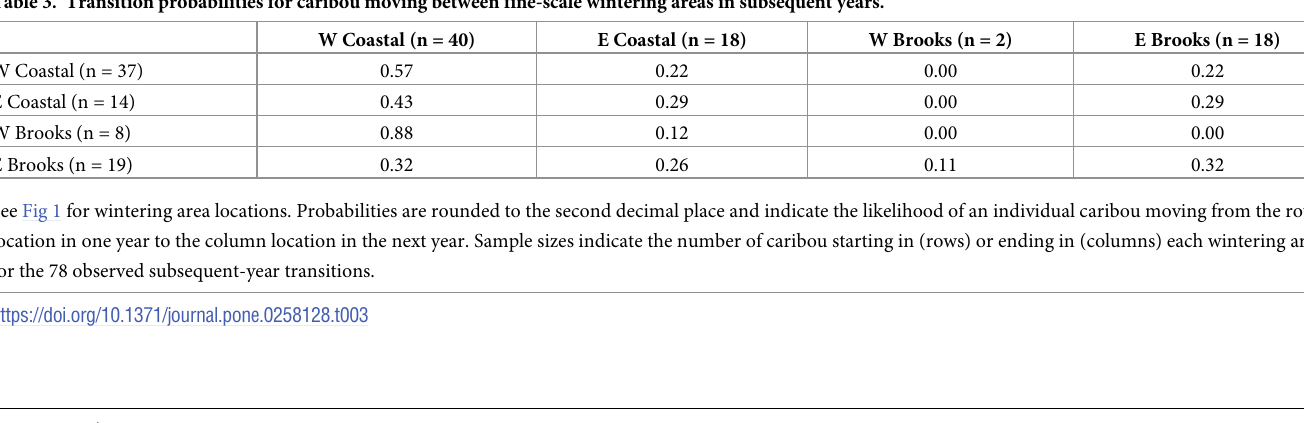
0.70 0.30 Probabilities are rounded to the second decimal place and indicate the likelihood of an individual caribou moving from the row location in one year to the column location in the next year. Sample sizes indicate the number of caribou starting in (rows) or ending in (columns) each wintering area for the 78 observed subsequent-year